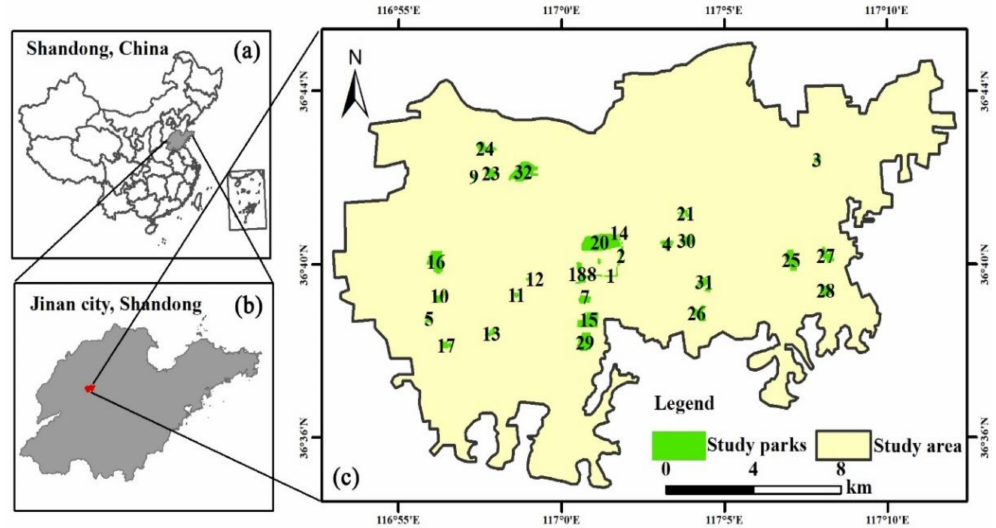
Figure 1. Location of study area: ( a ) Shandong province, China; ( b ) Jinan city in Shandong; ( c ) study parks in Jinan. High-spatial-resolution GF-2 images (1 × 1 m) acquired on 4 October 2018,